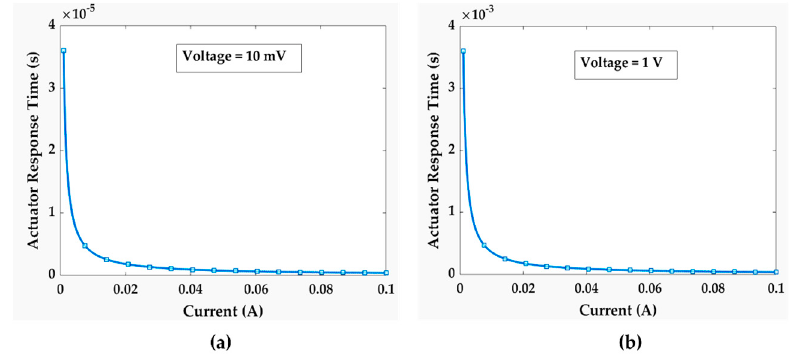
Figure 14. Actuator response time under different circuit conditions; ( a ) 10 mV; ( b ) 1 V.